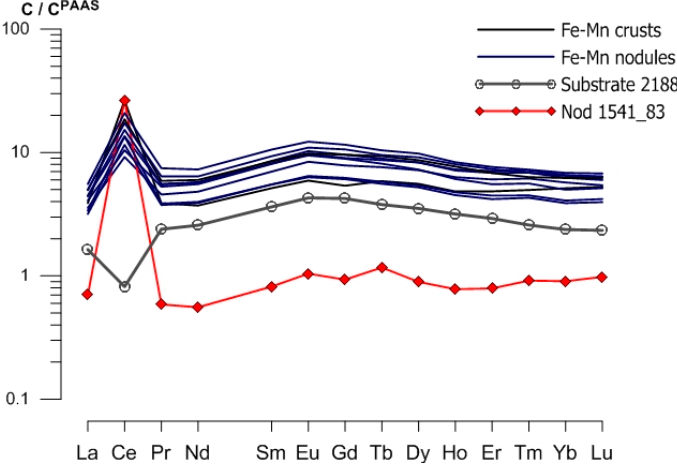
Figure 4. Normalized to Post Archean Australian Shale (PAAS) [42], the REE composition of studied ferromanganese nodules and crusts.